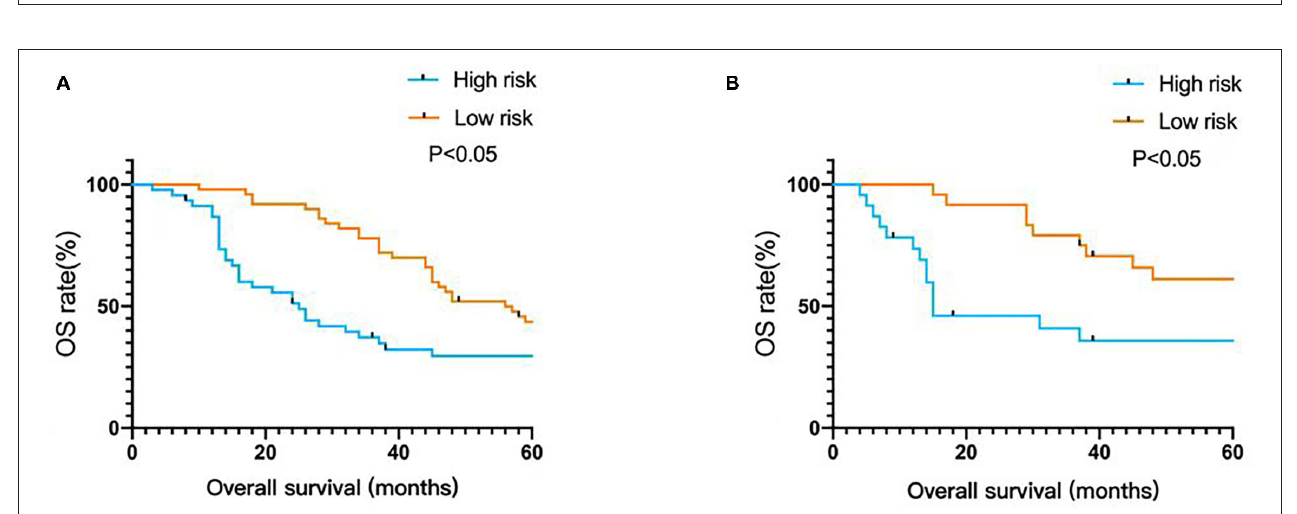
FIGURE 4 | Decision curve analysis for overall survival. (A) In the development cohort. (B) In the validation cohort. The Black line: no effect of relevant independent factors. Gray line: effect of relevant independent factors. The Blue dashed line: the model of nomogram.